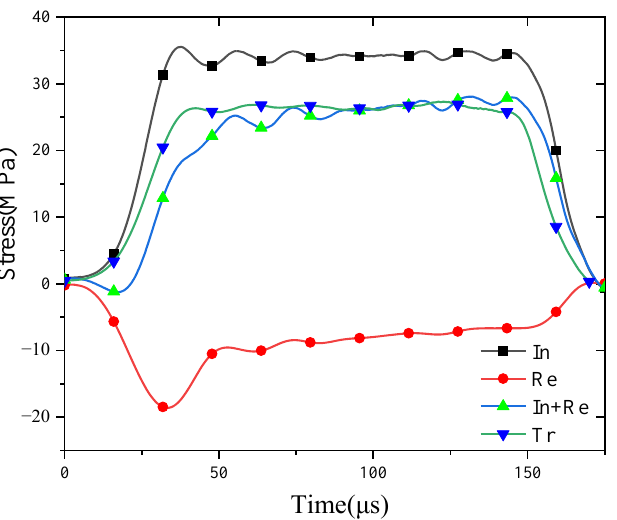
Figure 2. Verification of the dynamic stress equilibrium for typical specimens. Note: In, Re and Tr represent incident, reflected and transmitted, respectively.